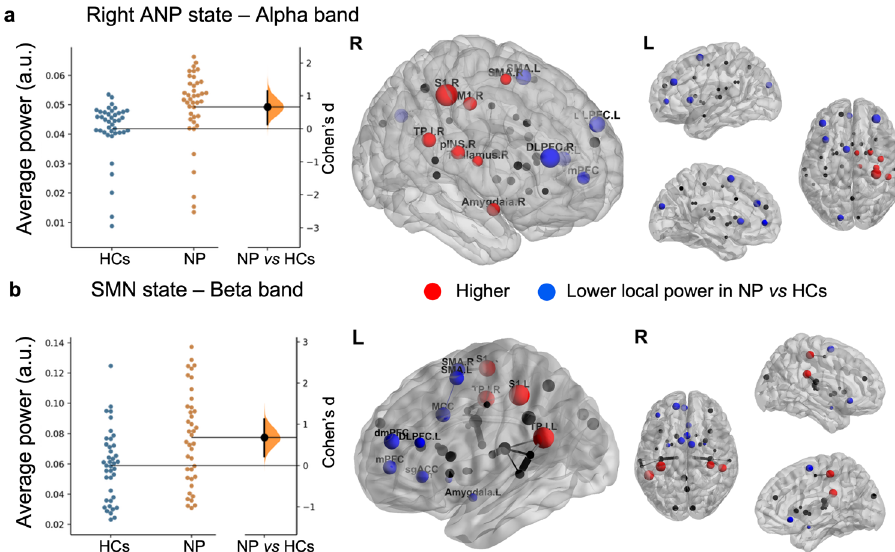
Fig. 3 Individuals with neuropathic pain had higher alpha power in the right ANP state and higher beta band power in the SMN state. Brain nodes in neuropathic pain (NP) showing signi fi cant local power increased (red nodes) and decreased (blue nodes) in the a right Ascending nociceptive pathway (ANP: higher alpha power in the right thalamus, primary somatosensory (S1), and motor cortex (M1), posterior insula (pINS), temporo-parietal junction (TPJ) and lower power in the dorsolateral prefrontal cortex (DLPFC), medial prefrontal cortex (mPFC), and left anterior insula (aINS) and b sensorimotor (SMN: S1 and TPJ, but had lower power in frontal regions including the DLPFC, mPFC, dorso-medial prefrontal cortex (dmPFC), subgenual anterior cingulate cortex (sgACC), midcingulate cortex (MCC) and sensorimotor area (SMA) state compared with healthy controls (HCs) are depicted. The effect size (Cohen ’ s d ) between the average power of n = 40 healthy controls and n = 40 individuals with neuropathic pain is shown in the Gardner-Altman estimation plots. 5000 bootstrap samples were taken; the con fi dence interval is bias-corrected and accelerated. Each dot on the brain maps represents a brain region, and its size is in relation to the difference in spectral power between the neuropathic pain and control groups (i.e., proportional to the effect size, larger dot means a stronger